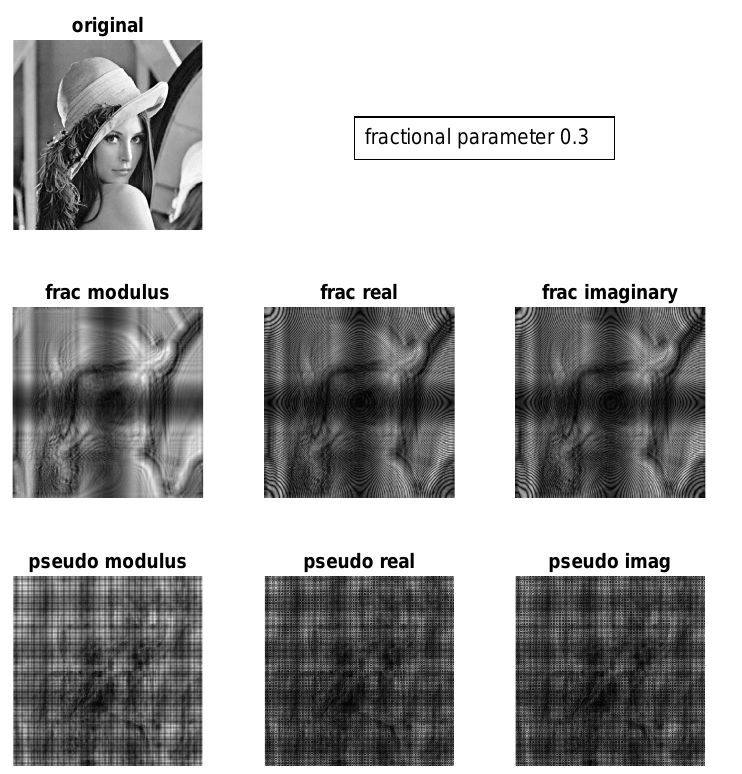
Figure 5. Comparison of DFrFT and DPFrFT of the grayscale image “Lena” for fractional parameter a = 0.3.